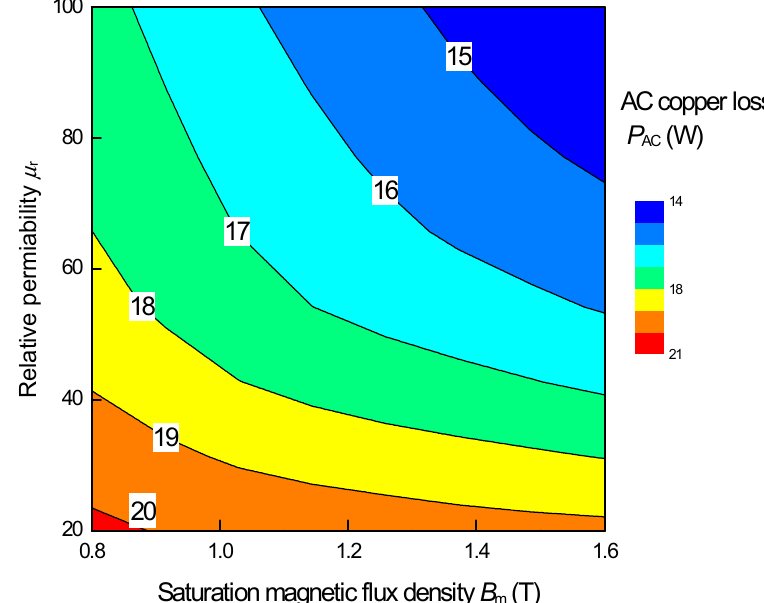
Figure 13. Distribution of AC copper loss in motors with hypothetical materials.